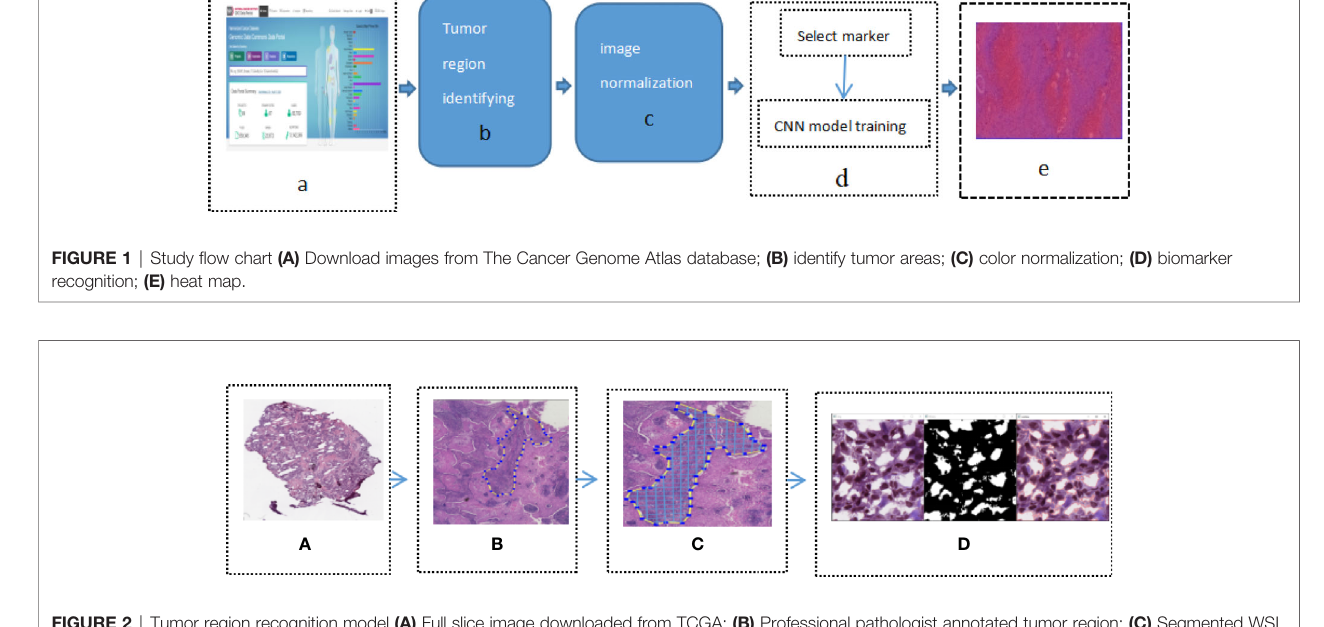
FIGURE 2 | Tumor region recognition model (A) Full slice image downloaded from TCGA; (B) Professional pathologist annotated tumor region; (C) Segmented WSI with 512 * 512 sliding window; (D) Block noise reduction